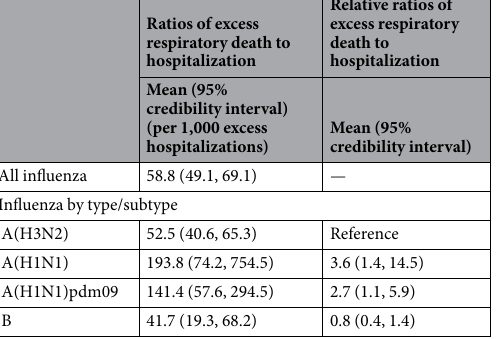
Table 3. Ratios of the influenza-associated annual excess respiratory death rate to the excess respiratory hospitalization rate by virus type/subtype and relative ratios of excess respiratory death to hospitalization for influenza A(H1N1), A(H1N1pdm09) and B compared to influenza A(H3N2) in Hong Kong population ≥ 65 years of age from January 1998 through June